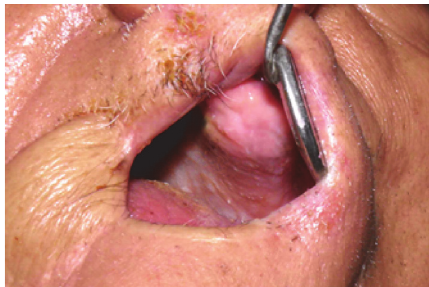
Figure 2: Intraoral view with maximum oral opening. Note the reduced aperture in relation to mouth mirror head.